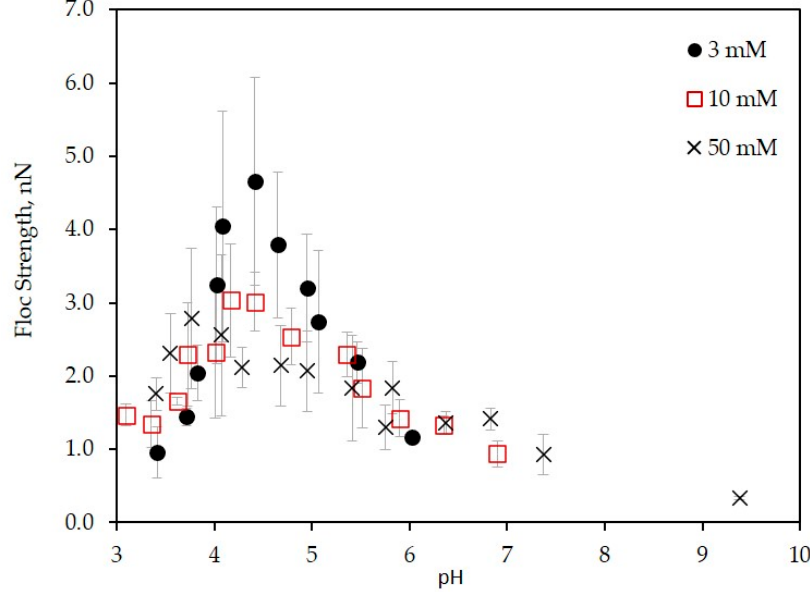
Figure 6. Floc strength of mass ratio CLSZ/CLHA = 2.5 at different KCl concentrations (3 mM, 10 mM, and 50 mM) as a function of pH.